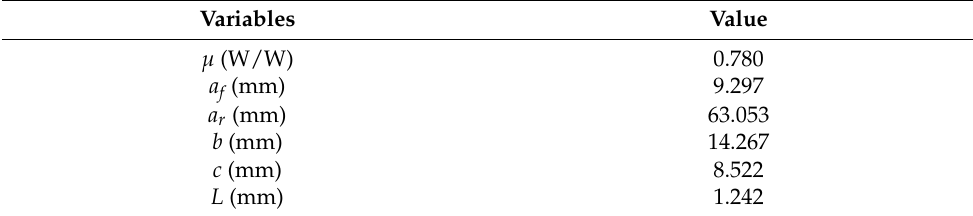
Table 6 . Derived heat source parameters .